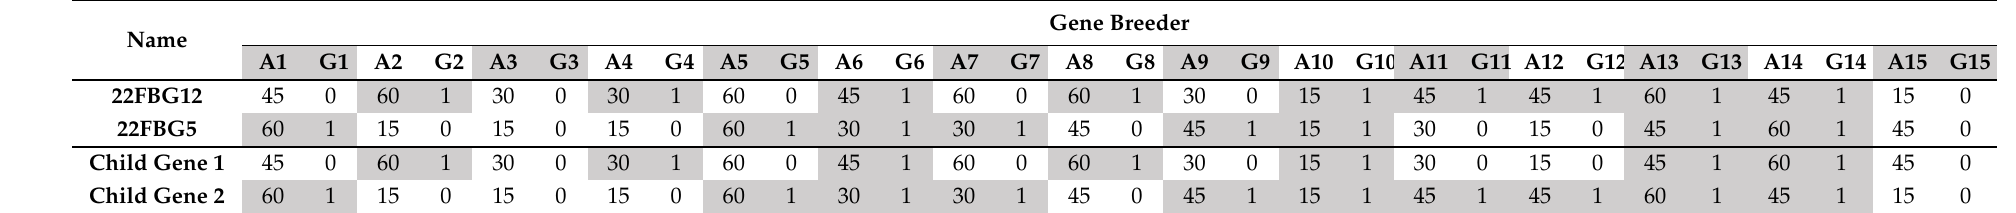
Table 2. Gene breeding example.